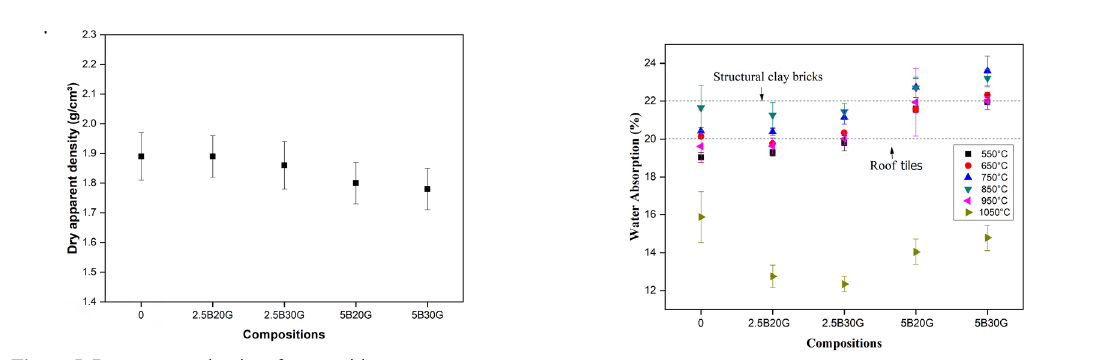
Figure 7. Water absorption of